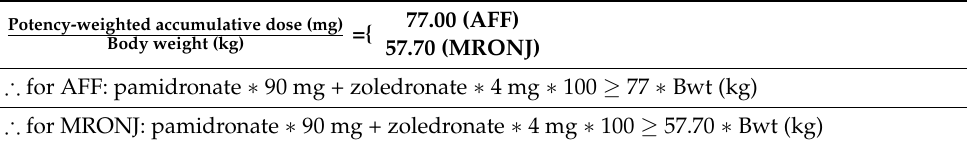
Table 3. Suggested cutoff for increased risks for AFF (OR = 7.300, p = 0.035) and MRONJ (OR = 3.201, p <